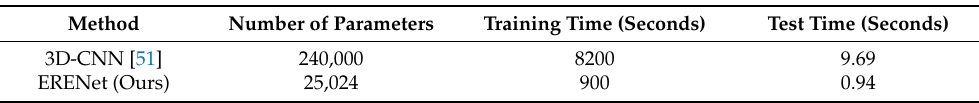
Table 8. The number of parameters, average training time, and average test time of 3D-CNN [51] and ERENet in the mixed-subject classification